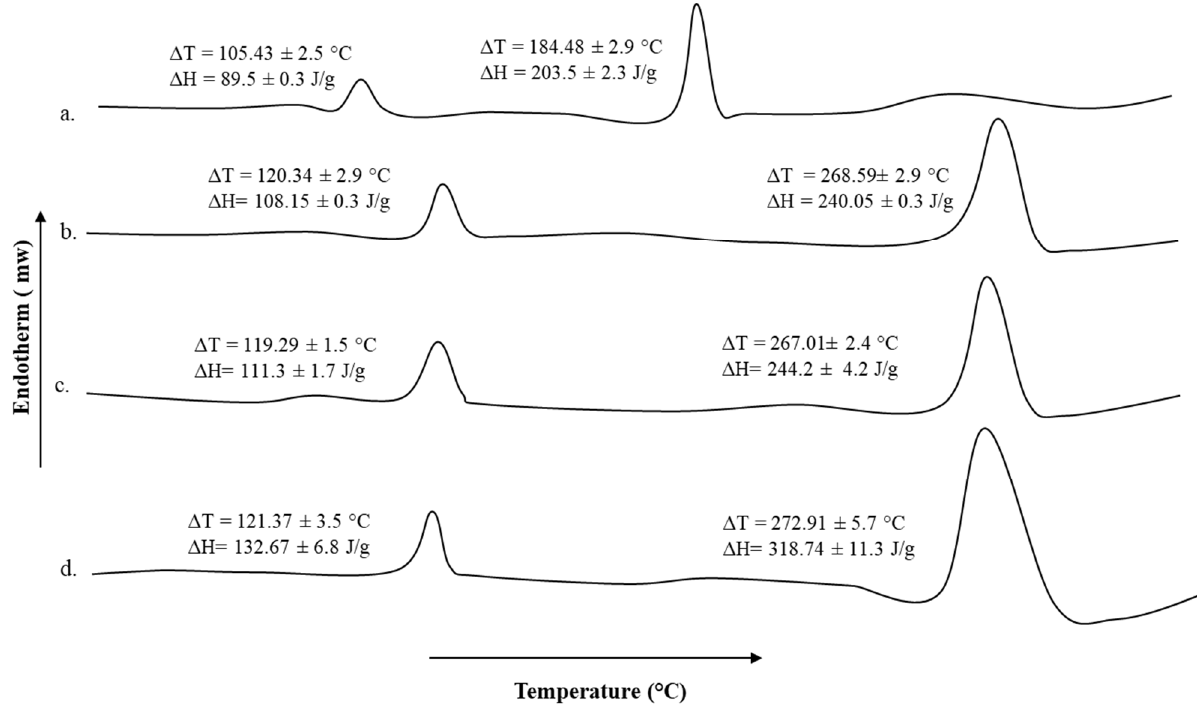
Figure 4. DSC thermogram of ( a ) untreated, ( b ) 1 min, ( c ) 3 min, and ( d ) 5 min microwave treated pectin and sodium alginate blend film.